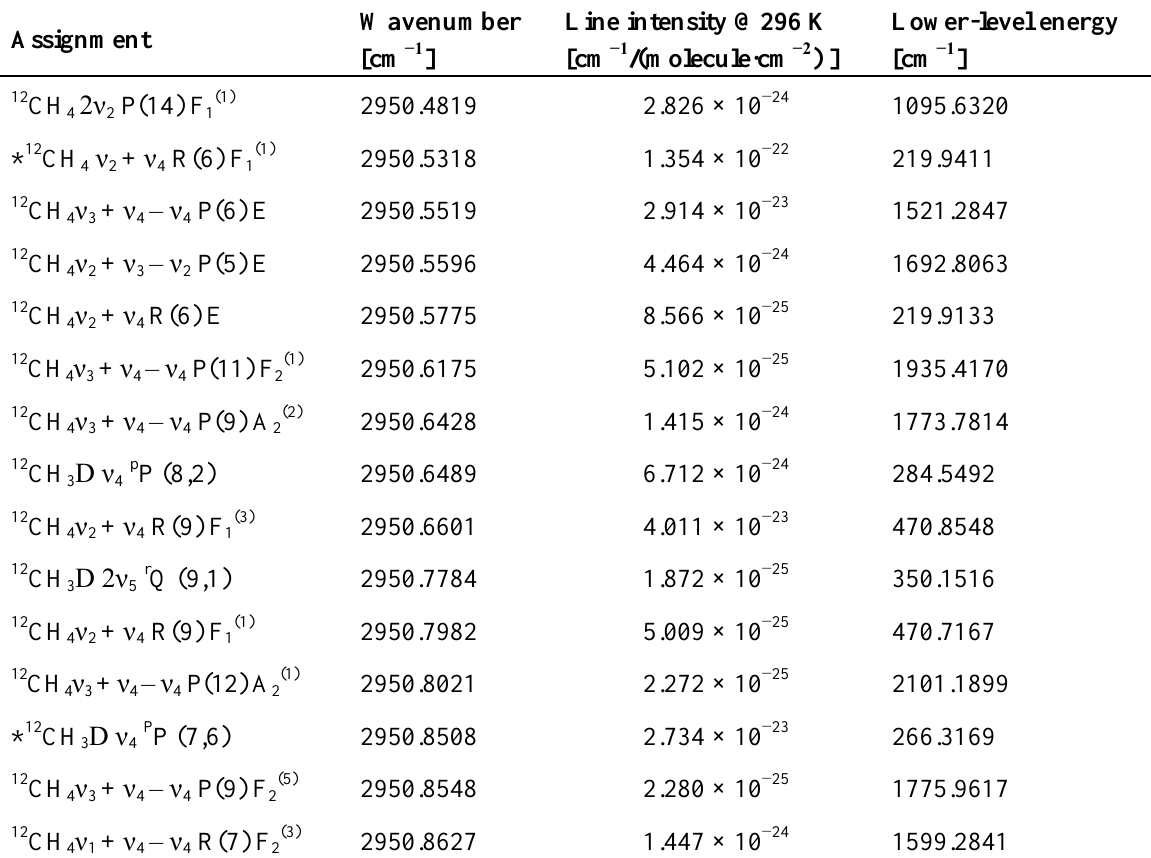
Table 1. Absorption lines of 12 CH measurement (HITRAN 2008 [27]).